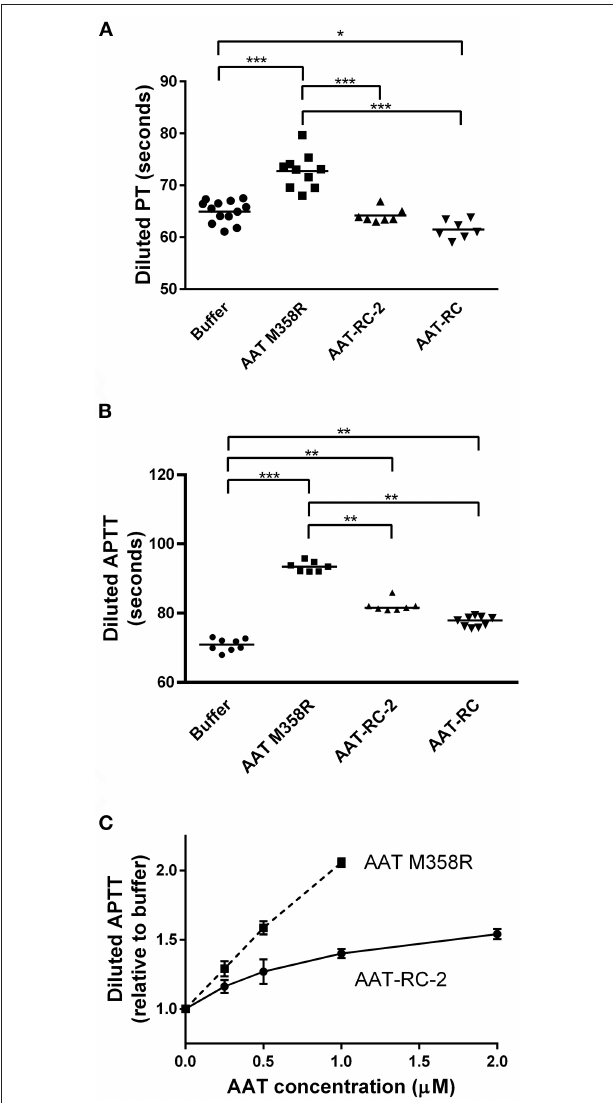
FIGURE 4 | Effects of AAT variants on modified hemostasis screening tests. Buffer or purified AAT M358R was introduced at 0.5 µ M final concentrations into diluted PT (A) or diluted APTT (B) assays. Note that the y-axis does not commence at 0s on any graph. Each point represents a single determination. Horizontal capped lines that link different groups indicate statistical differences by ANOVA with post-tests: * p < 0.05; ** p < 0.01; and *** p < 0.001. (C) A dose-response curve that shows diluted APTT values (normalized to buffer-only controls) as a function of increasing variant AAT concentration ( µ M). The mean ± SD of three determinations for each point is shown: squares, AAT M358R; circles,